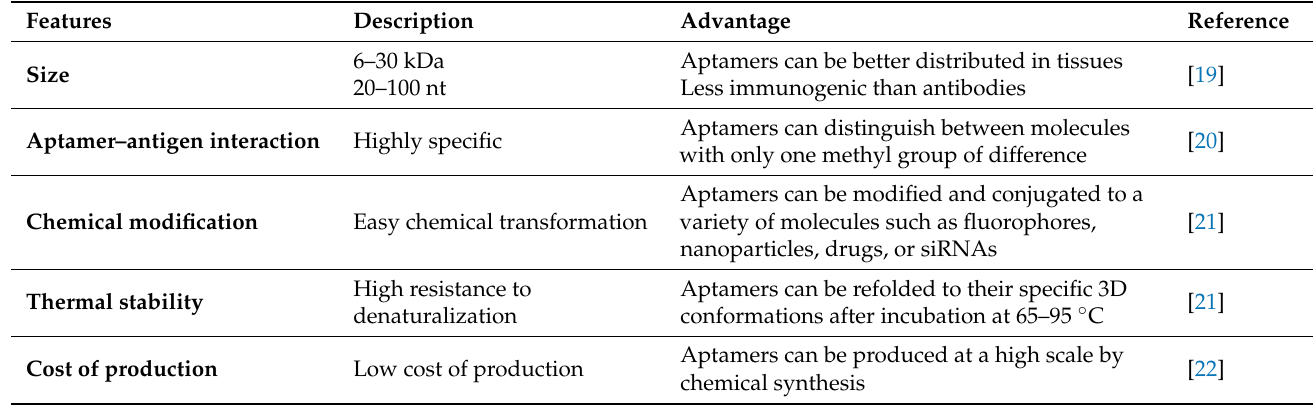
Table 1. Advantages of aptamers over antibodies.